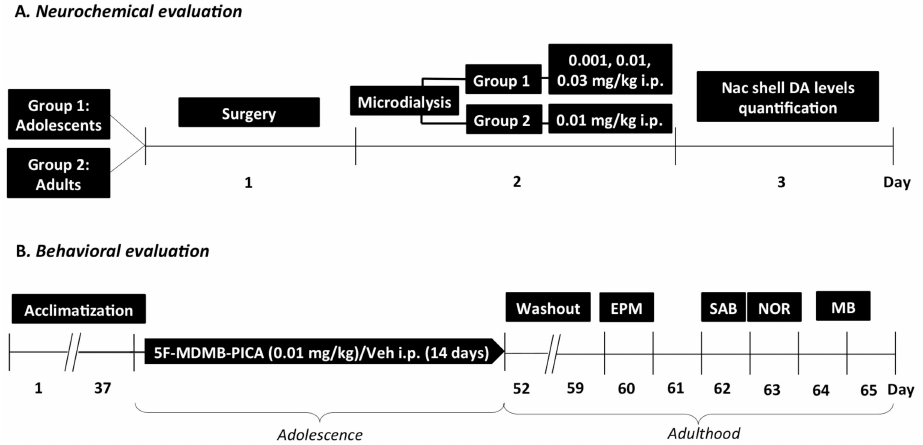
Figure 2. ( A )Experimentalscheduleofacutetreatmentwith5F-MDMB-PICA(0.001,0.01, and0.3mg / kgi.p.) for NAc shell DA levels quantification in adolescent and adult (0.01 mg / kg i.p.) mice by in vivo brain microdialysis. ( B ) Experimental schedule of the repeated treatment with 5F-MDMB-PICA (0.01 mg / kg) or vehicle (intraperitoneal) during adolescence and of behavioral tests at adulthood in male mice. EPM, elevated plus maze. SAB, spontaneous alternation behavior in a Y-maze. NOR, novel object recognition. MB, marble burying